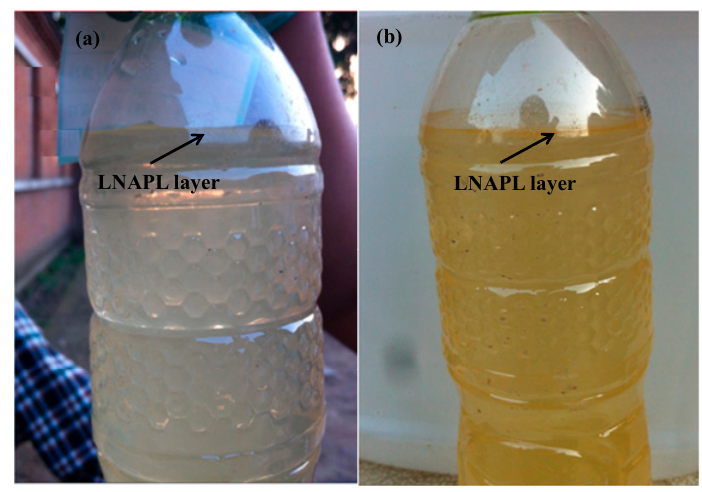
Figure 10. Light non-aqueous phase liquid (LNAPL) in groundwater samples at monitoring wells. ( a ) Groundwater from 8 m depth aquifer; ( b ) groundwater from 15 m depth aquifer.